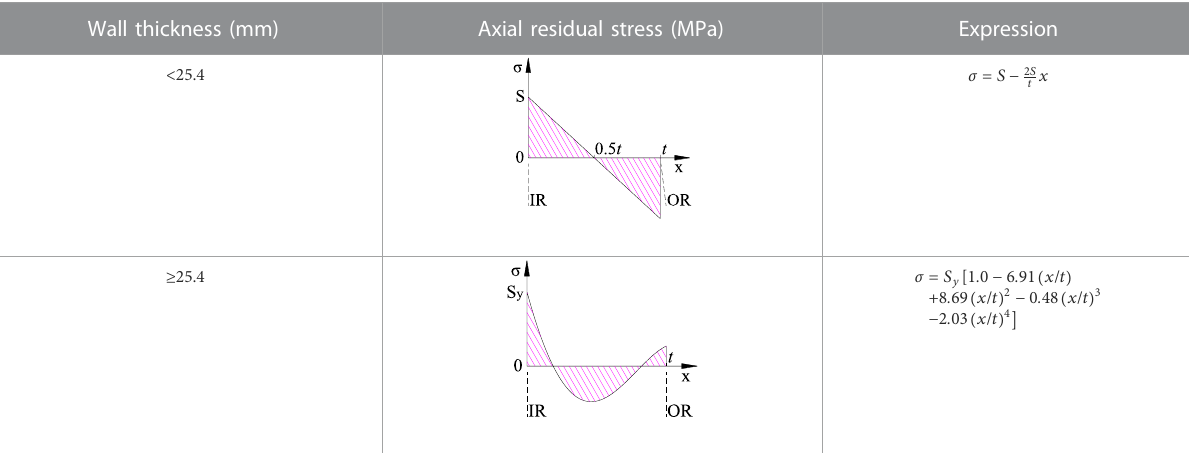
TABLE 1 The WRS recommended by the TGPFE (EPRI, 1986).